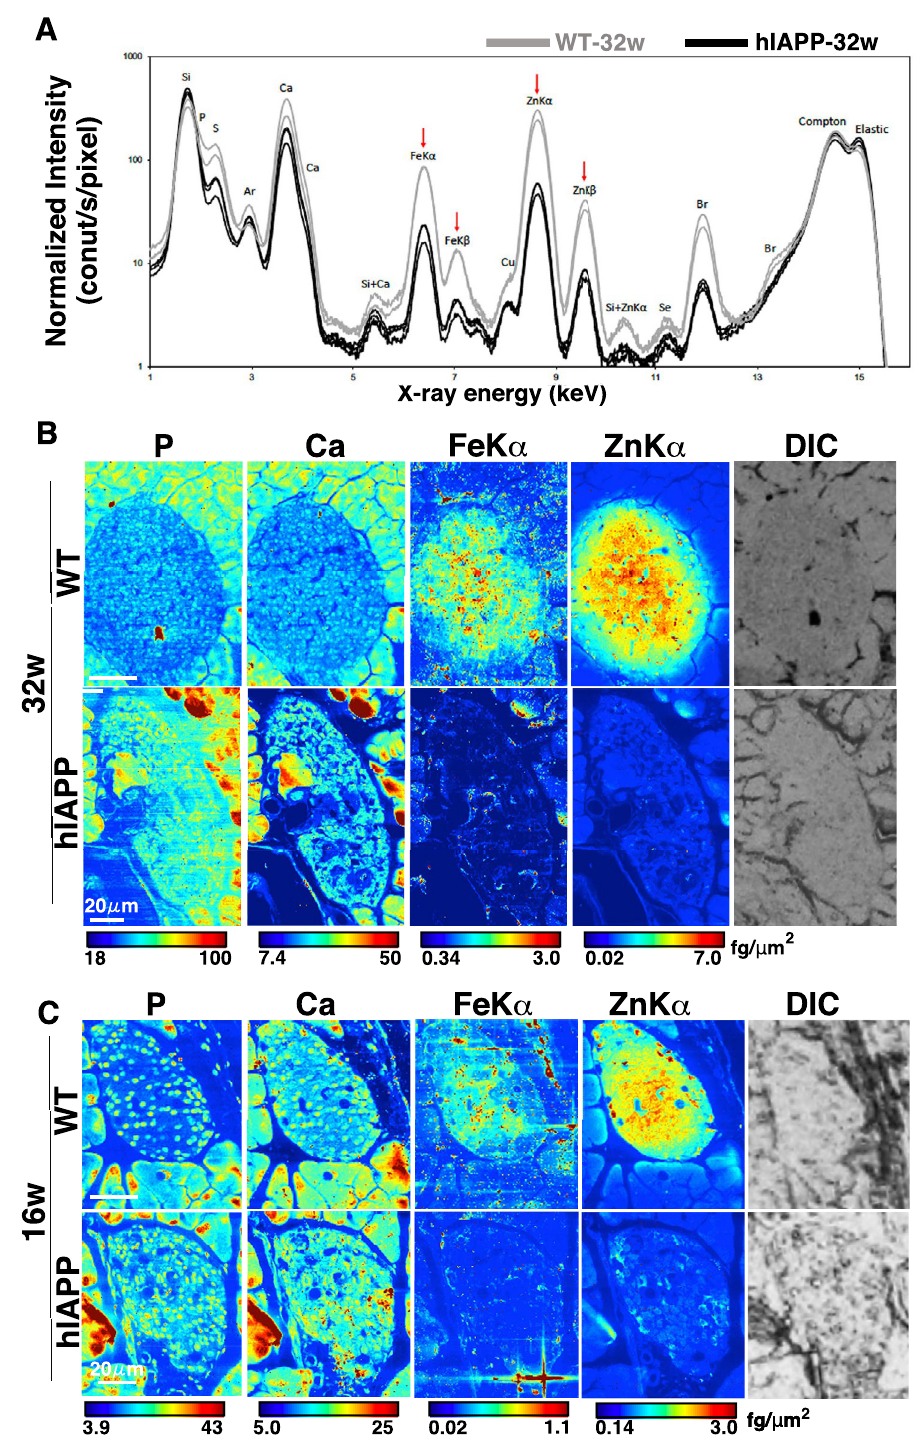
Figure 2. X-ray fluorescence images of islets from 16- and 32-week-old WT and hIAPP-Tg mice. ( A ) X-ray fluorescence spectra of islet sections from 32-week-old mice. Arrows indicate peak signals of FeKα, FeKβ, ZnKα, and ZnKβ x-ray emission lines. Measurement was performed three times for each section. Gray line: a spectrum for a section from control mouse; black line: a spectrum for a section from hIAPP. X-ray energy, 15 keV; beam size, 500 × 500 nm. ( B ) Representative mapping images of ( A ). ( C ) Mapping images of islets from indicated 16-week-old mice. WT: WT mice, hIAPP: hIAPP-Tg mice, Color bar, femtograms per square micrometer; DIC: differential interference contrast image; Scale bar, 20